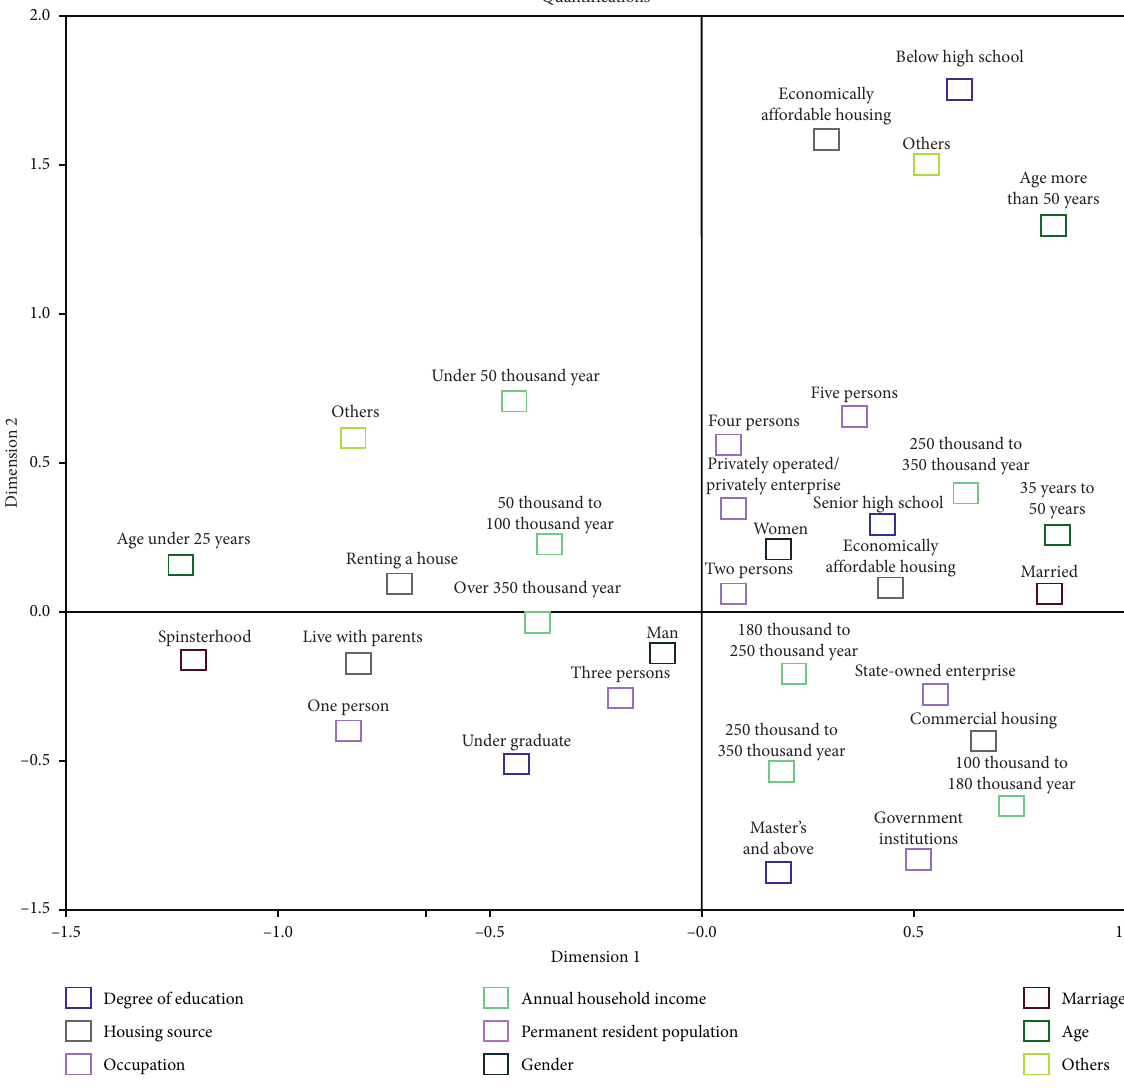
Figure 2: Quantitative scatter plot of multivariate correspondence analysis.